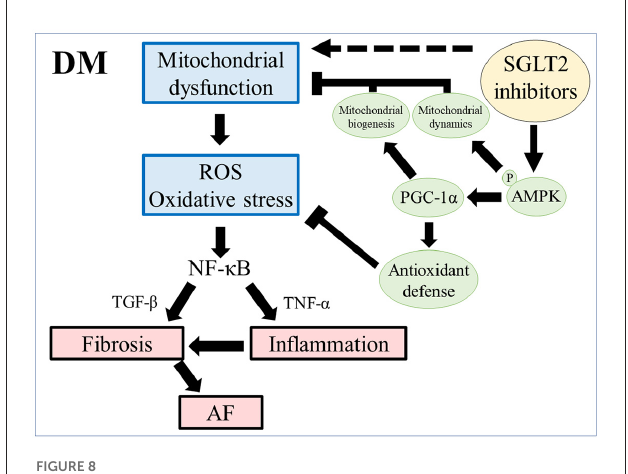
FIGURE8 Scheme of atrial remodeling via mitochondrial dysfunction in rats with DM. ROS, reactive oxygen species; NF- κ B, nuclear factor- κ B; TGF- β , transforming growth factor- β ; TNF- α , tumor necrosis factor- α ; AF, atrial fibrillation; pAMPK, phosphorylated AMP-activated protein kinase; PGC-1 α , peroxisome proliferator-activated receptor γ coactivator-1 α .